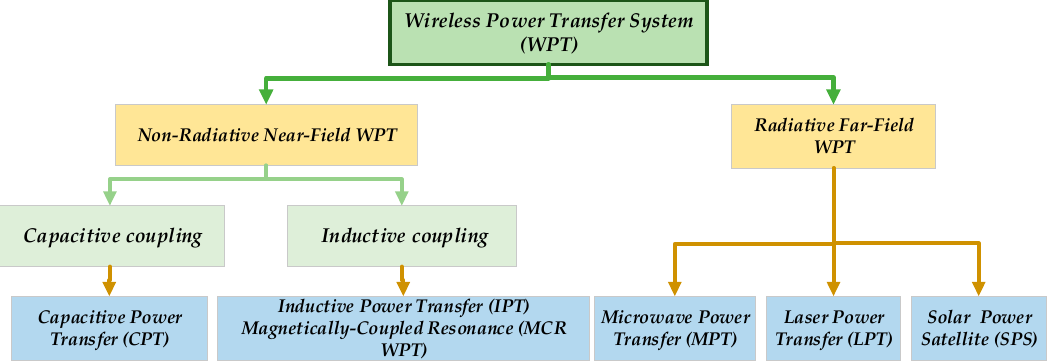
Figure 1. Wireless power transfer (WPT) classifications.